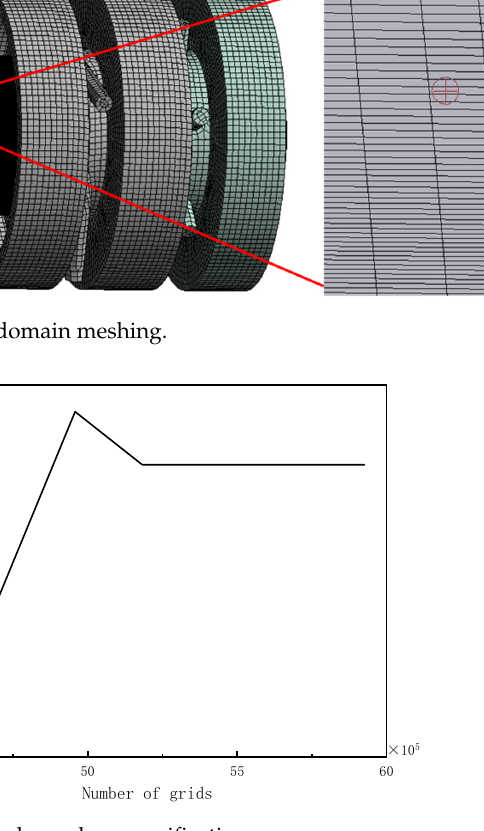
Figure 7. Grid-independence verification.